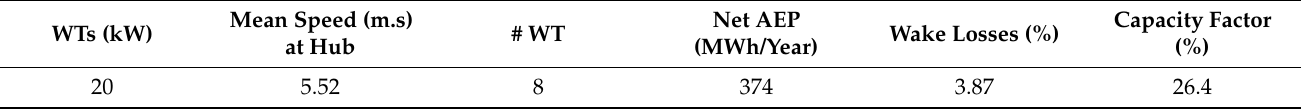
Table 6. Lampedusa wind technical